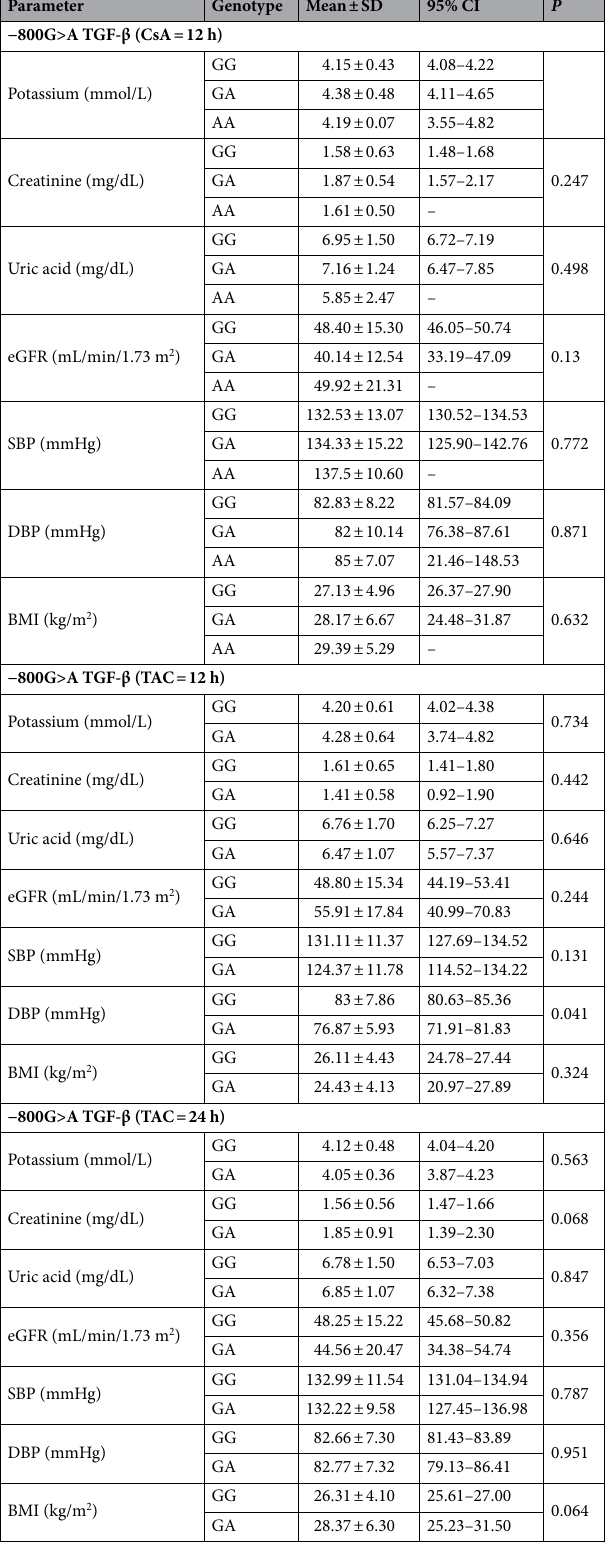
Table 6. Analysis of the selected clinical parameters and biochemical parameters of the renal profile in relation to the genotypes of TGF-β1 -800G>A polymorphism (rs1800468).n (CsA-12 h, n = 183), (TAC-12 h, deviation (SD). P-significance level for the difference between the groups (one-way